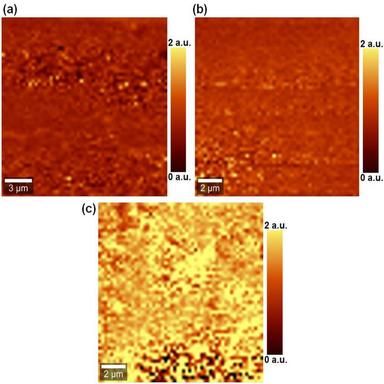
Raman mapping of D-to-G peak intensity ratio for (a) Janus Ppy-GAC nanocomposite (b) Ppy nanoparticles and (c) GAC.